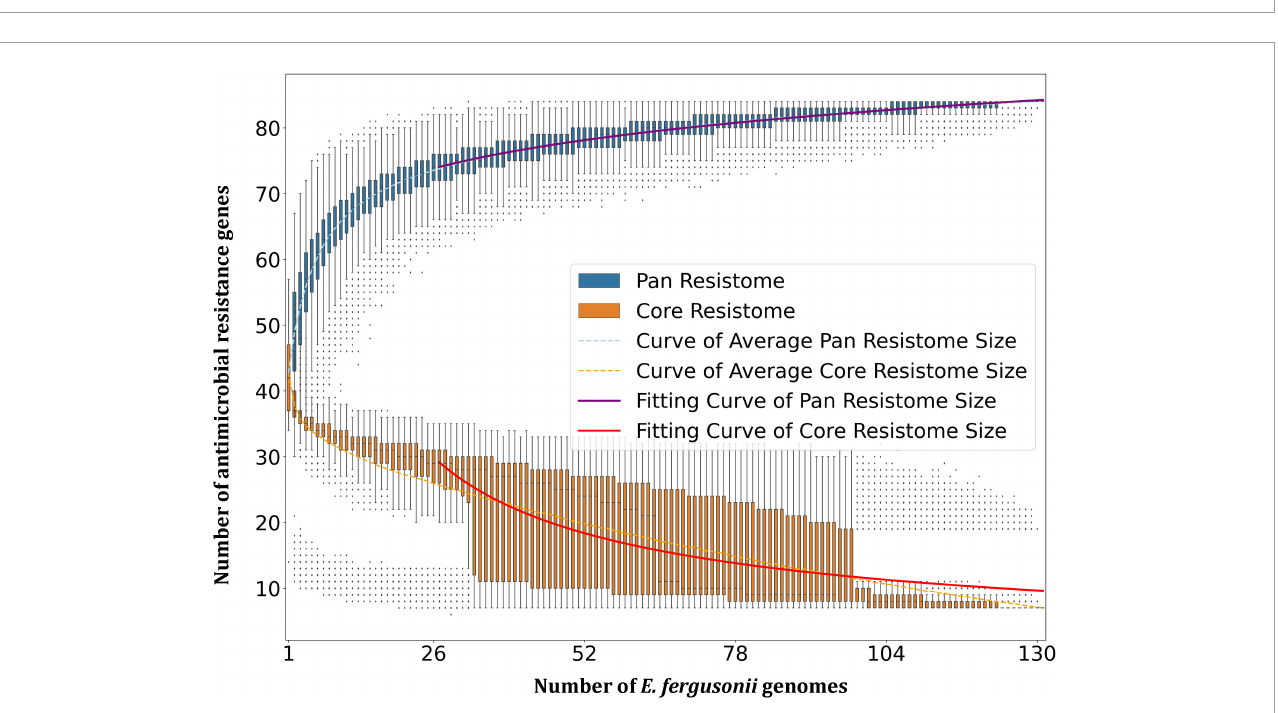
FIGURE3 Pan-resistome and core-resistome development trends of E. fergusonii